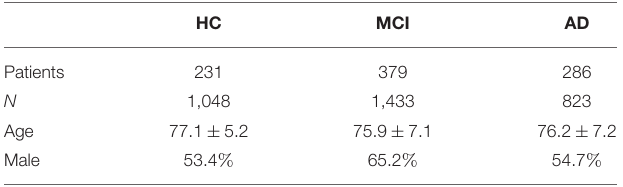
TABLE 1 | Demographic details of the selected ADNI dataset cohort, distributed over the three classes. HC